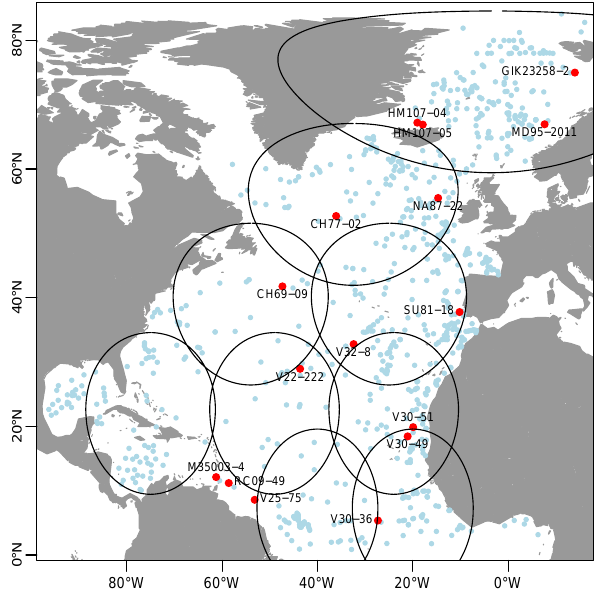
Fig. 1. Map of the North Atlantic Ocean showing calibration set sites (pale blue), core sites (red), and the 1400-km-radius circles for testing the regional performance of transfer